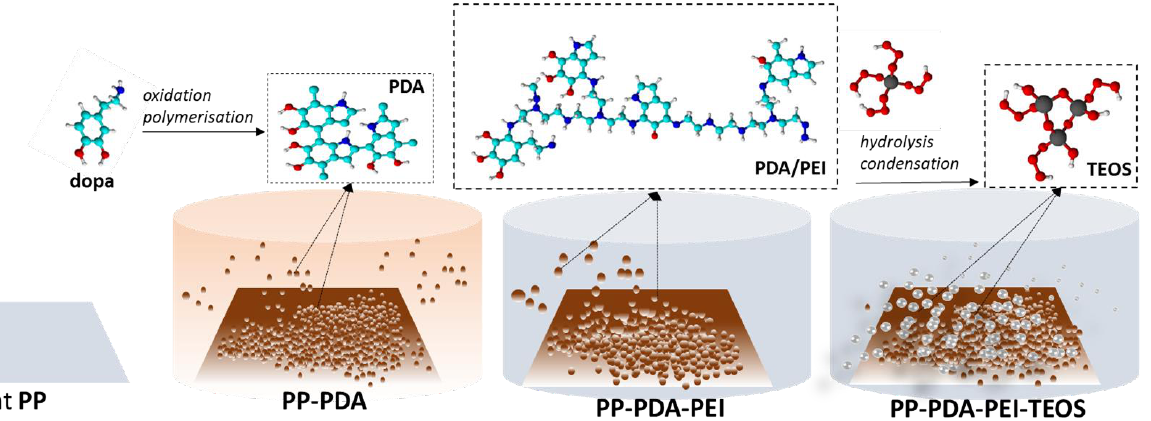
Figure 2. Schematic illustration of reaction mechanism for PDA/PEI-supported TEOS deposition on PP film.